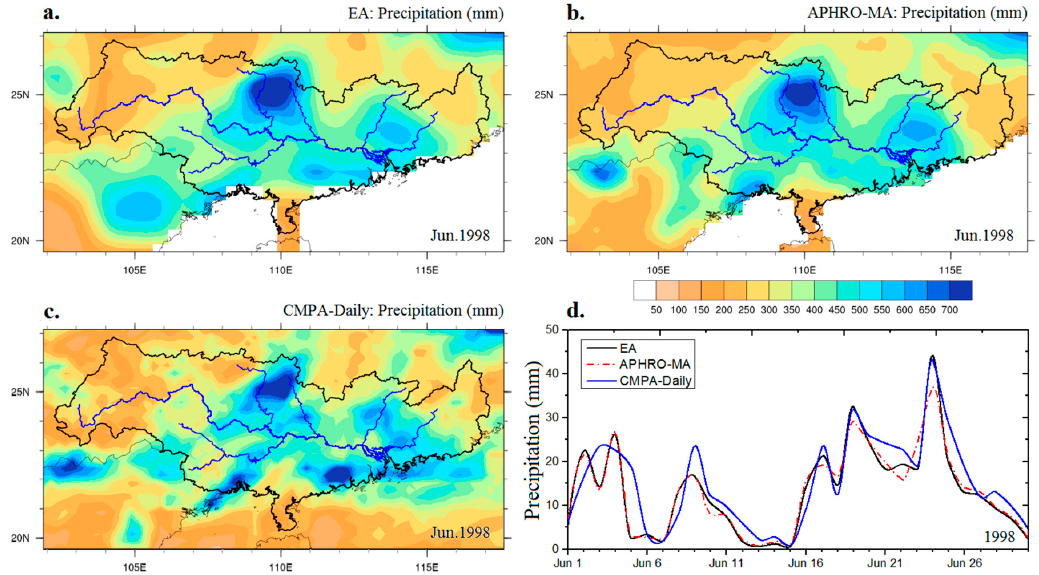
Figure 3. Comparison of precipitation in June 1998 for monthly rainfall distribution from ( a ) East Asia (EA); ( b ) Asian Precipitation Highly-Resolved Observational Data Integration Towards Evaluation dataset for Monsoon Asia (APHRO-MA); ( c ) high-resolution gauge satellite-merged China Merged Precipitation Analysis (CMPA)-Daily; and ( d ) the regional daily average precipitation for three precipitation forcings.